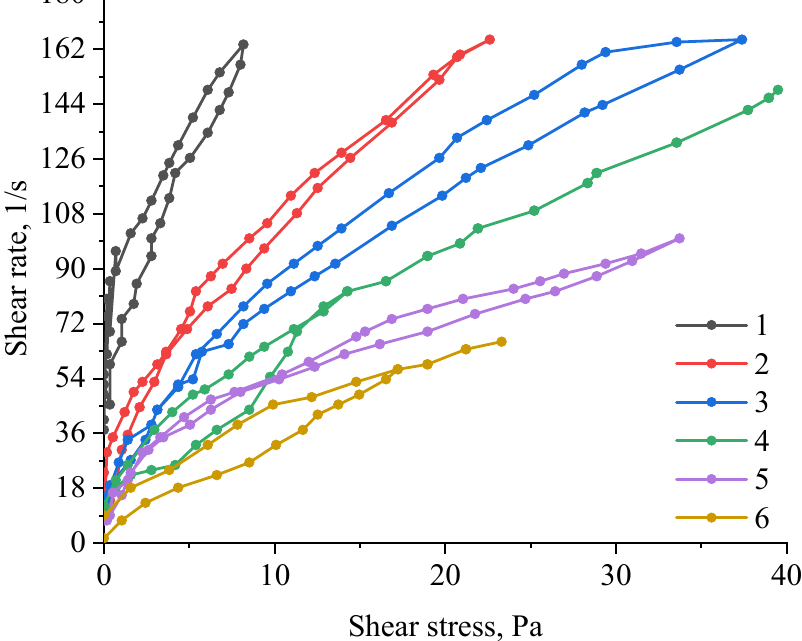
Analysis of SEM micrographs of nanoscale ZnO showed that the samples of ZnO